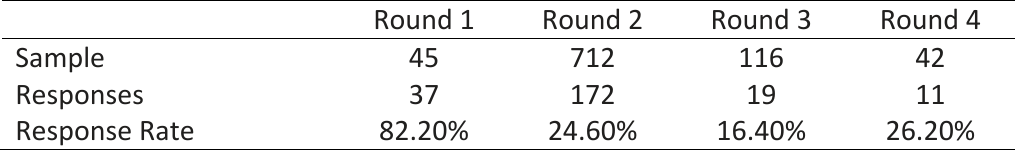
Response Rates for each Round of Data Collection